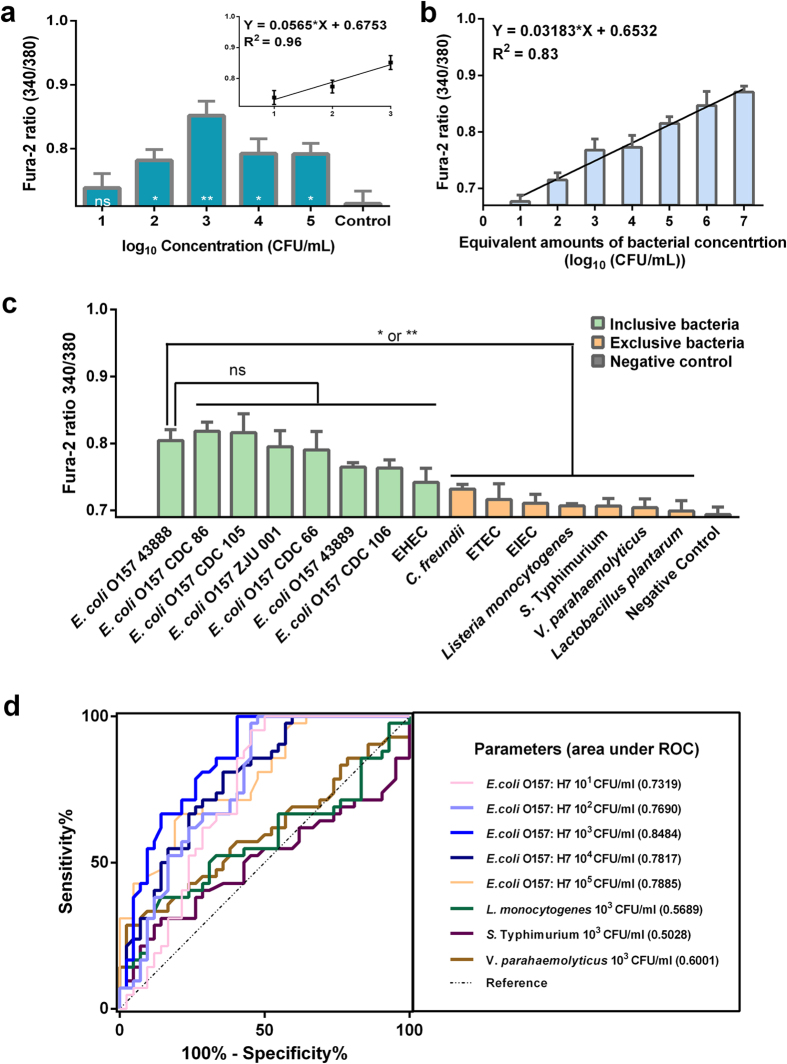
Detection of E. coli O157:H7 in pure culture. (a). Plot of the biosensor’s response, Fura-2 ratios, to different concentrations of E. coli O157:H7 in pure culture. Insert: Linear calibration curve obtained for E. coli O157:H7 in the range of concentrations from 101 to 103 CFU/mL. All data shown is mean±s.e.m. and p-value obtained by unpaired t-test. (two-tailed, nsp > 0.05, *p < 0.05, **p < 0.01, n = 4). (b). Plot of the biosensor’s response, Fura-2 ratios, to different concentrations of LPS extracted from E. coli O157:H7 which is equal to bacterial concentrations from 101 to 107 CFU/mL. All data shown is mean±s.e.m. and p-value obtained by unpaired t-test. (two-tailed, nsp > 0.05, *p < 0.05, **p < 0.01, n = 3). (c). Inclusivity tests and exclusivity tests to compare the B cell biosensor’s response to target and non-target bacteria species at 103 CFU/mL. All data shown is mean±s.e.m. and p-value obtained by unpaired t-test. (two-tailed, nsp > 0.05, *p < 0.05, **p < 0.01, n = 3). (d). ROC curves for all sensitivity sets and specificity sets with three replicates in bacteria pure culture conducted continuously for 30 min.